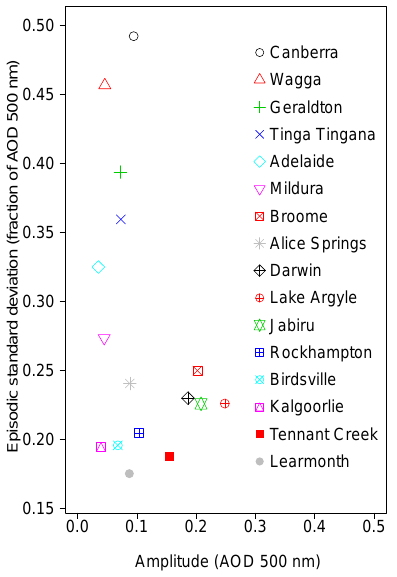
Figure 8. Plot of the amplitudes of the sinusoidal components with a period of 4 months (vertical axis) against the amplitude of the 6- monthly component (horizontal axis), both relative to the 12-month amplitude. The relative 4-monthly amplitude controls the extent of double-peaking in the spring–summer period.